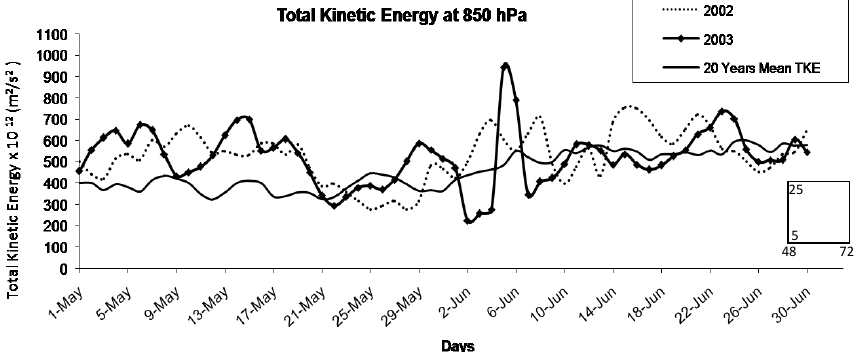
Fig. 5. Variation of Total kinetic energy from 1 May–30 June during 2002 and 2003 over the domain 48 ◦ E–72 ◦ E and 5 ◦ N–25 ◦ N (Arabian Sea domain) compared with the mean total kinetic energy Fig (5): Variation of Total kinetic energy from 1 st May – 30 th June during 2002 & 2003 over the domain 48 0 E-72 0 E & 5 0 N-25 0 N (Arabian Sea domain) compared with the mean Total kinetic energy (1990-2009).